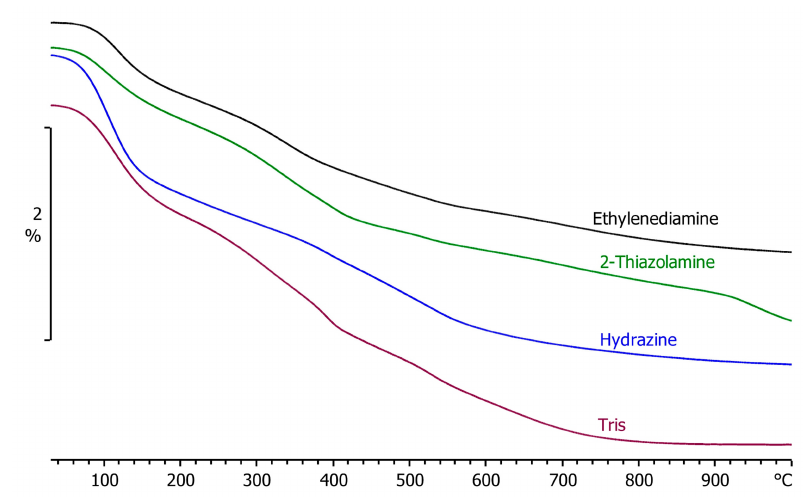
Figure 5. TGA curves showing the percent weight loss during heating for ZnO powders prepared using four different precursors. The amine label by the curve corresponds to the amine used during synthesis of the